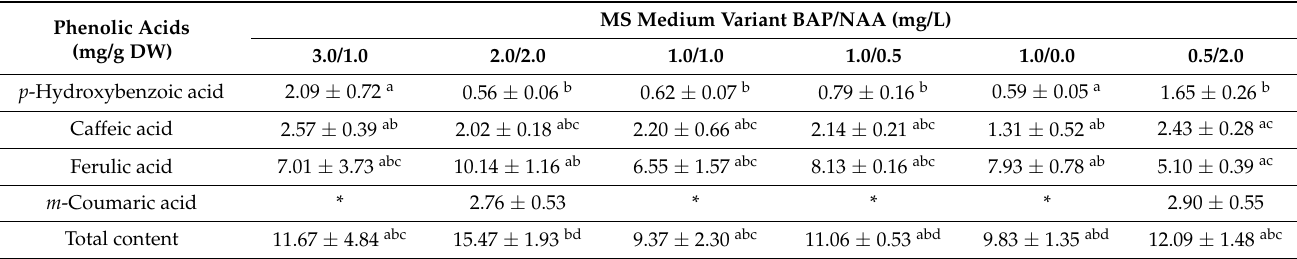
Table 3. Phenolic acid content in biomass extracts of Scutellaria brevibracteata subsp. subvelutina in vitro cultures (MS medium variants with BAP and NAA; 4-week growth cycle).